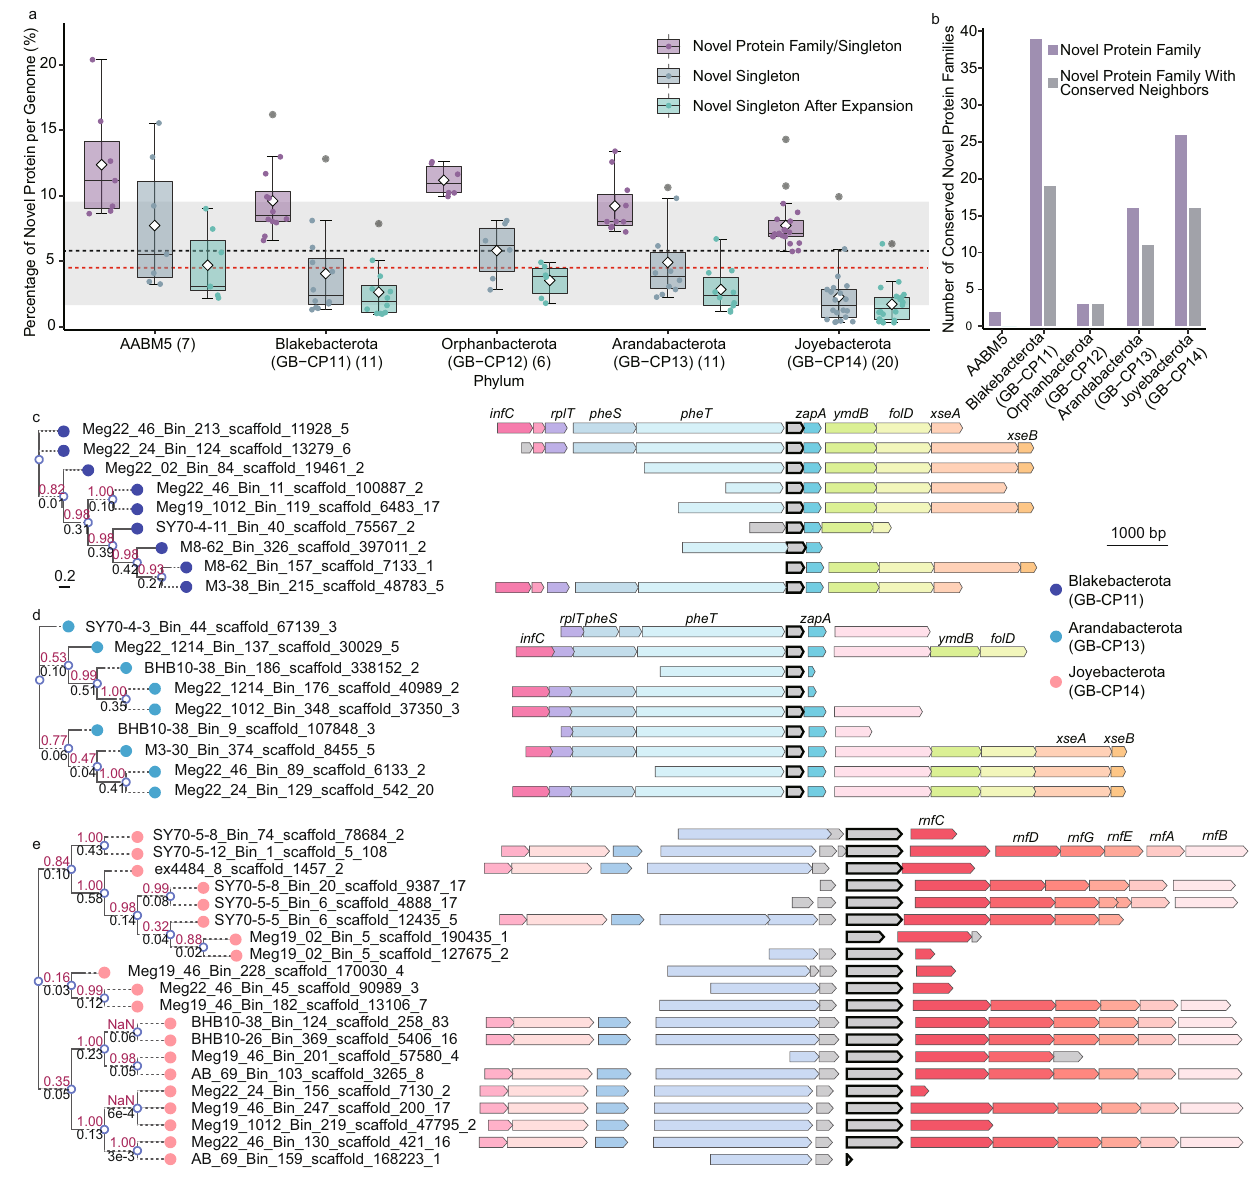
Fig. 2 | Novel protein families in the fi ve newly described phyla. a Box plot showing the percentage of novel proteins in the proteomes of the fi ve newly described phyla. The number of genomes within each phylum recovered in this study are shown in parentheses ( n =7, 11, 6, 11, and 20 for AABM5, Blakebacterota, Orphanbacterota,Arandabacterota,and Joyebacterota,respectively).The box plot showsthe fi rstand thirdquartiles (topandbottomofthebox),median (horizontal line inside the box), mean (diamond inside the box), lower and upper extremes (whiskers), outliers (dark gray dots), and single data points (dots color coded by theirrespective box).The dashed blackand red linesdenote the meanand median of the percentage of novel protein families per genome in the 169,642 genomic collections, and the gray background shows their standard deviation. For exam- ple, AABM5 and Joyebacterota have the highest and lowest percentage of novel families. b Number of conserved novel protein families highly speci fi c (speci fi city > 0.7) and widespread (coverage > 0.7) within each phylum are shown in dark